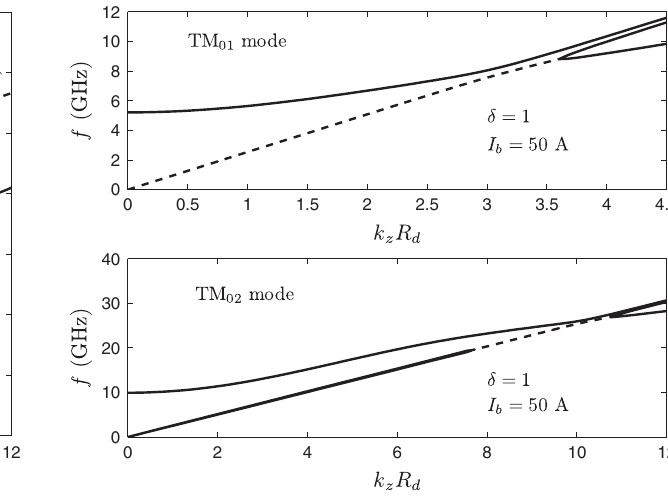
FIG. 4. Real part of TM 01 and TM 02 dispersion relation for FIG. 2. Cold dispersion relation for the Cerenkov maser for the TM ¼ 2 cm , R ¼ 1 : 5 cm , and (cid:3) ¼ TM 50 A beam with (cid:1) ¼ 1 . The unstable regions of the dispersion 01 and 02 modes with R 0 d 4 showing the beam line with (cid:5) ¼ 0 : 8 (340 relation are shown in the dashed lines.